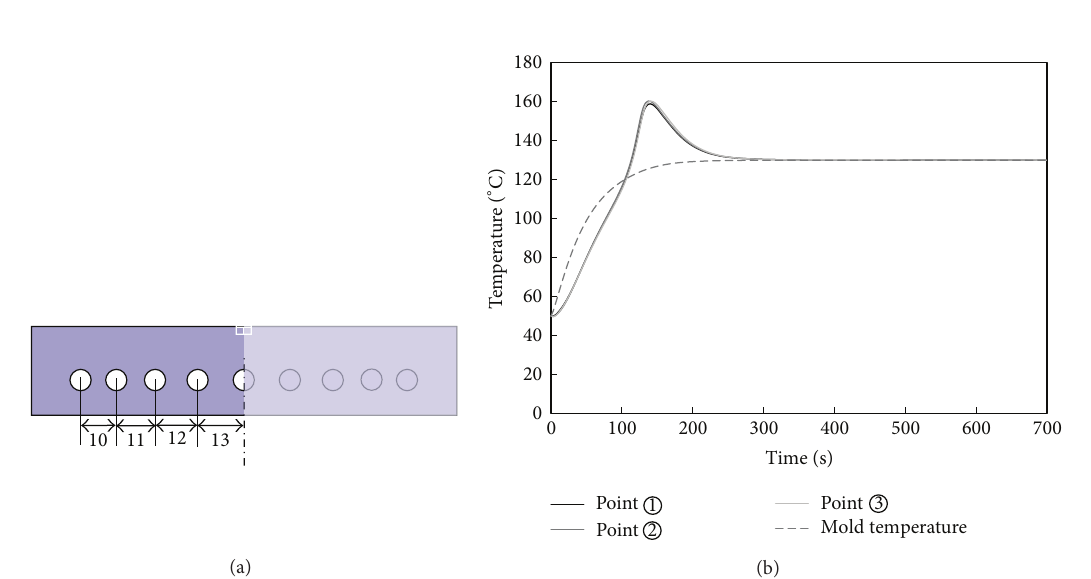
Figure 8: Temperature profile of large area LED lens molding. (a) Measuring points of silicone resin and mold temperature. (b) Temperature profile of silicone resin and mold.